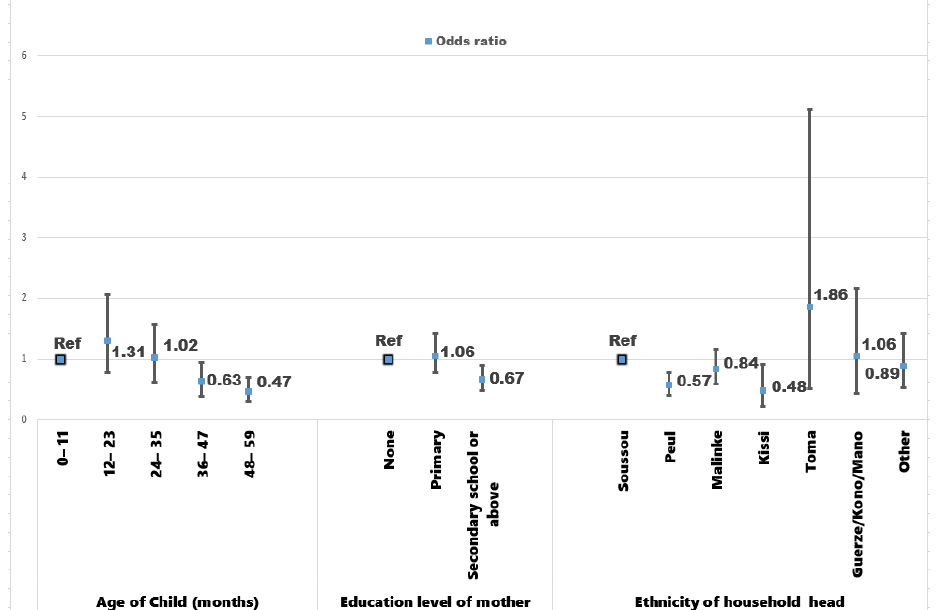
Figure 1. Factors associated with anemia from the model by including non-spatial random effects.